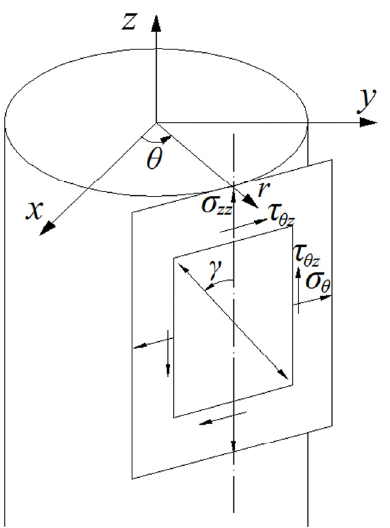
Figure 3. Stress state on the borehole